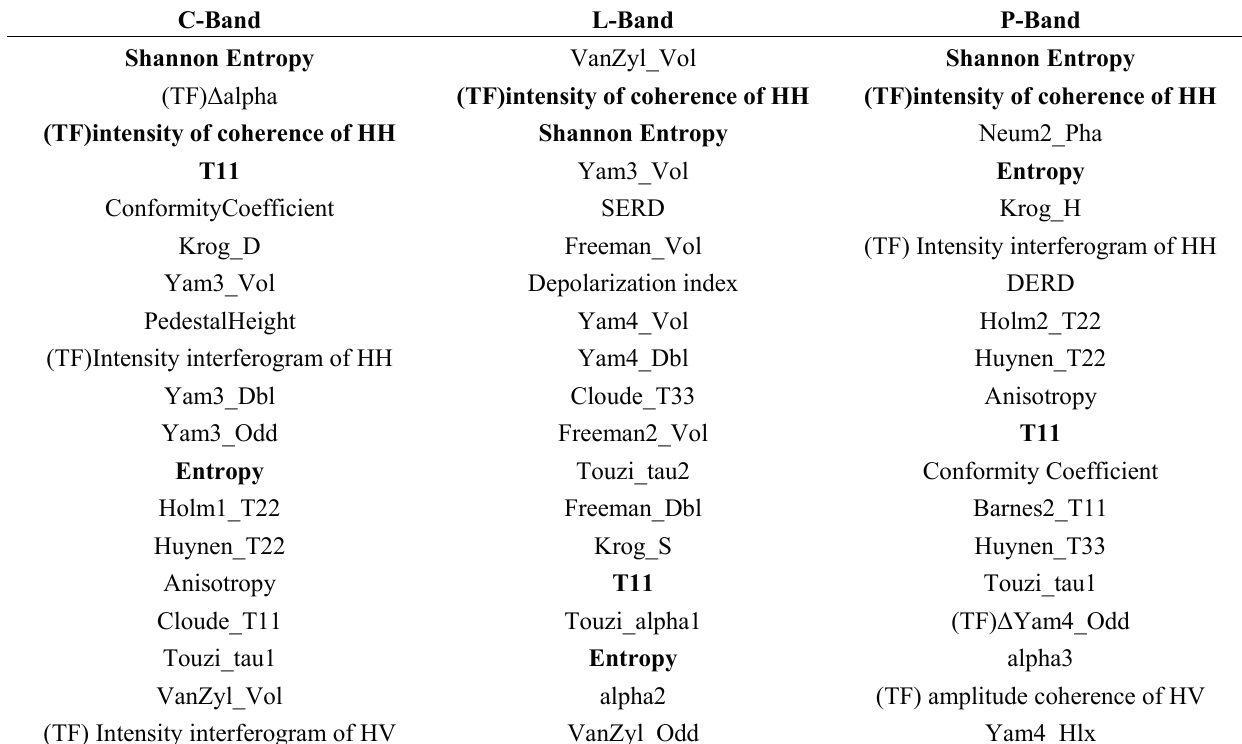
Table 11. Top 20% of features in the proposed method of C-, L- and P-band.